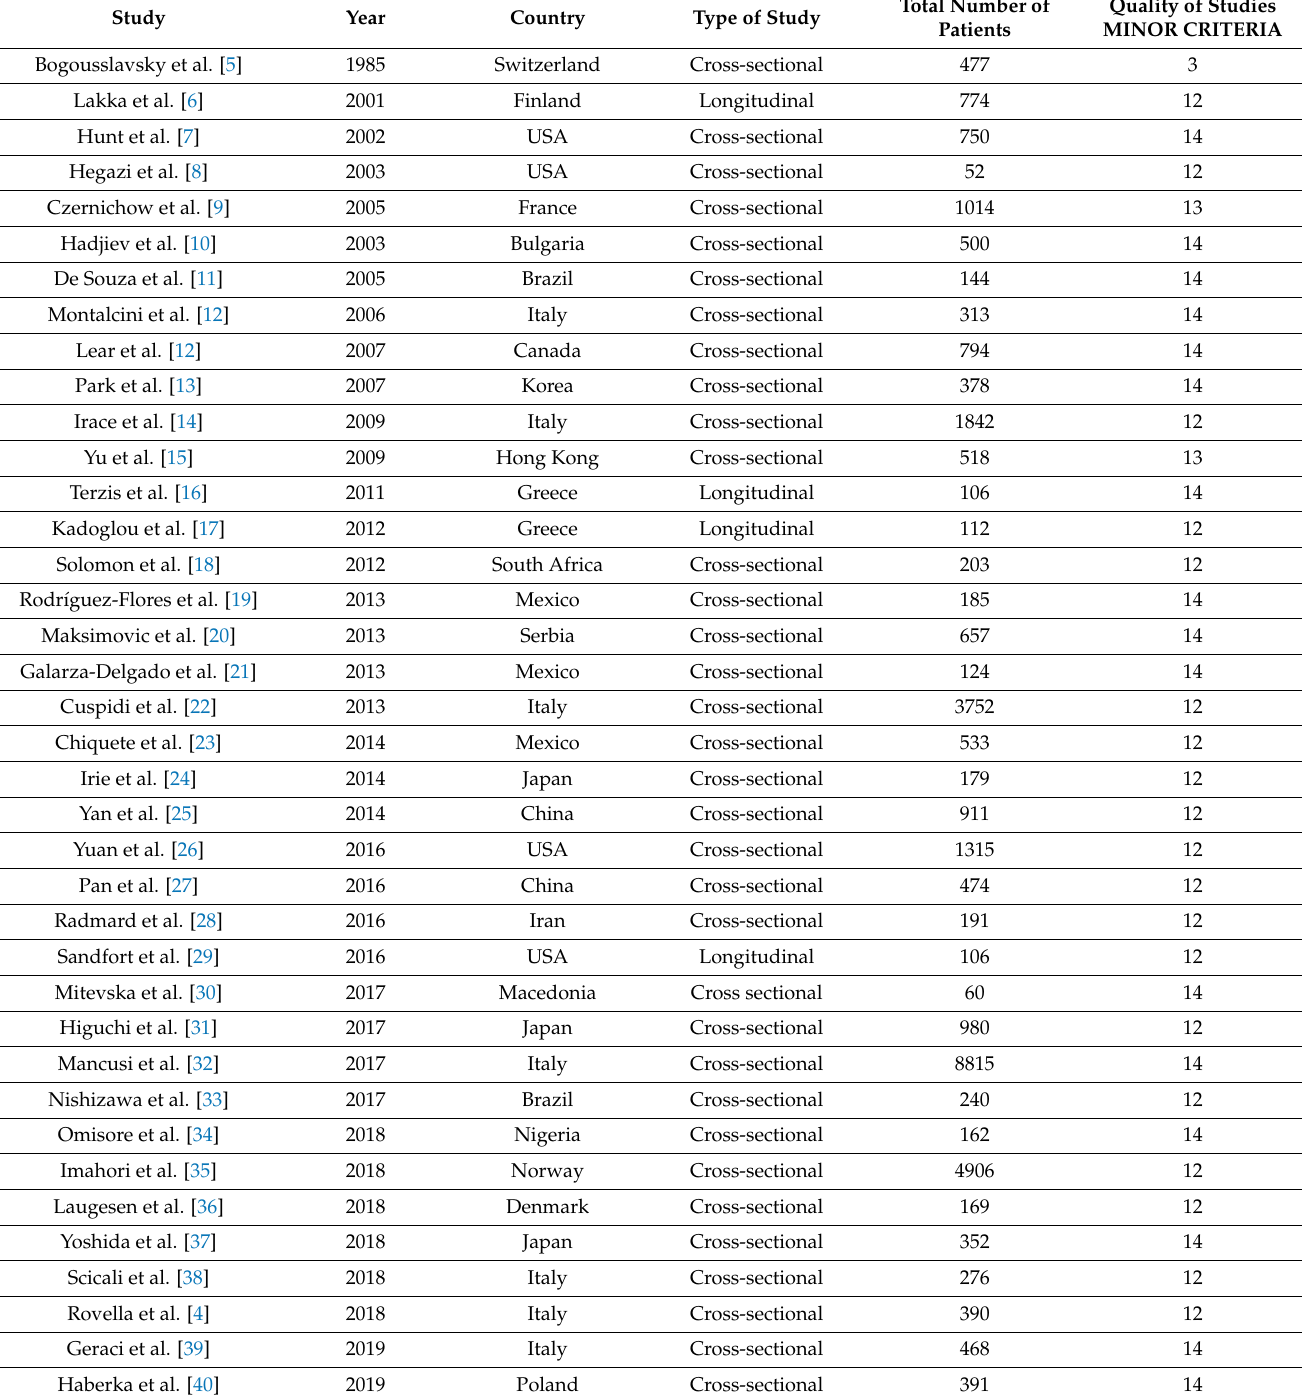
Table 1. Characteristics of the studies included in the opportunistic